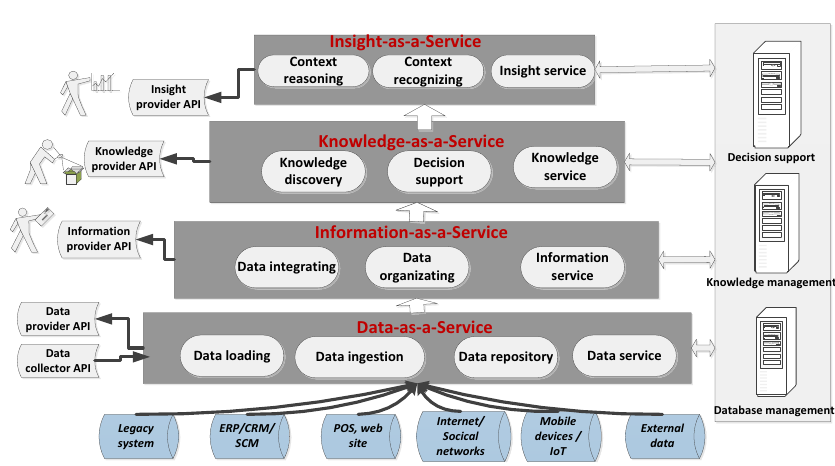
Fig. 1. A knowledge-based smart service